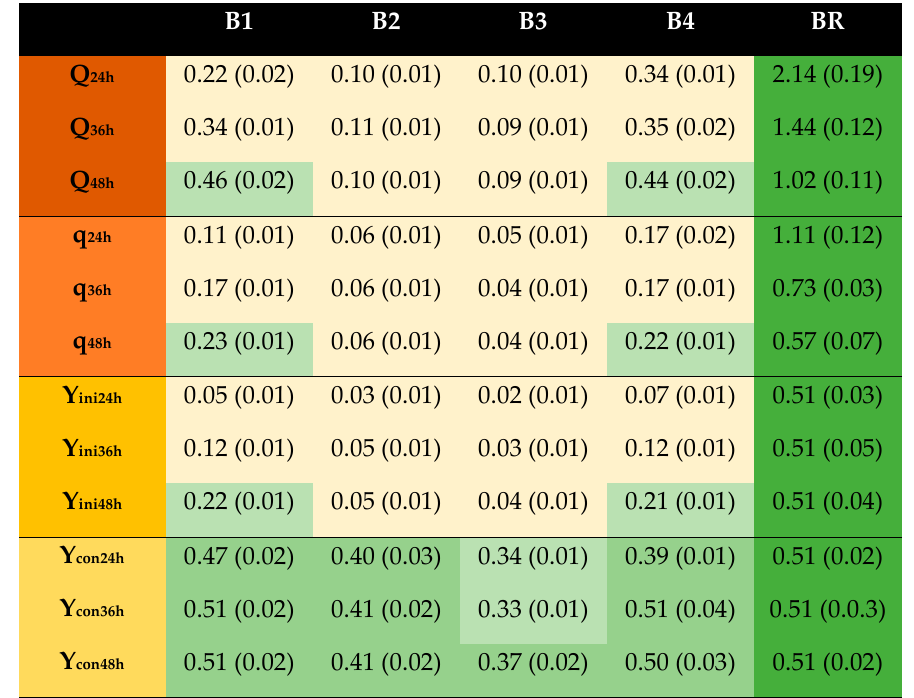
Figure 2. Results of the second experimental series (B) of the fermentation of detoxified and undetoxified Norway spruce hydrolysates with S. cerevisiae . The codes refer to conditions detailed in Table 1.Calculations are based on the results obtained after 24 h, 36 h, and 48 h of fermentation. Standard deviations are shown in parentheses. Color scheme: